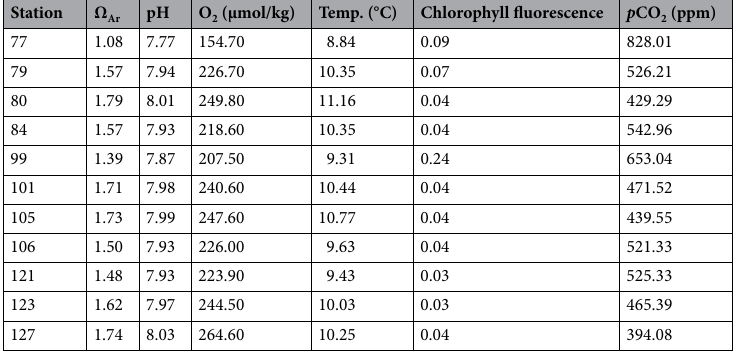
deeper (below 50 and 130 m) in the offshore regions (Fig. 1a) due to coastal upwelling. This resulted in a pro- nounced acidification gradient, with a depth-averaged Ω Ar over the upper 100 m of the water column ranging from 1.08 onshore to 1.79 offshore and depth-averaged pH ranging from 7.77 to 8.03 (Fig. 1b,c, Table 1). In addition, depth-averaged temperature and dissolved oxygen concentrations also increased substantially from the onshore to the offshore stations (Fig. 1d, Table 1). In fact, all measured ocean variables (Ω Ar , pH, p CO 2 , tem- perature, oxygen) except chlorophyll fluorescence, were strongly correlated with each other along this upwelling gradient (Fig. 2a). PC1 explains 83.0% of the environmental variability among stations, and essentially reflects the offshore-onshore gradients driven by coastal upwelling. PC2 explains 11.9% of the variability, and is largely related to variation in chlorophyll fluorescence (Fig. 2a).